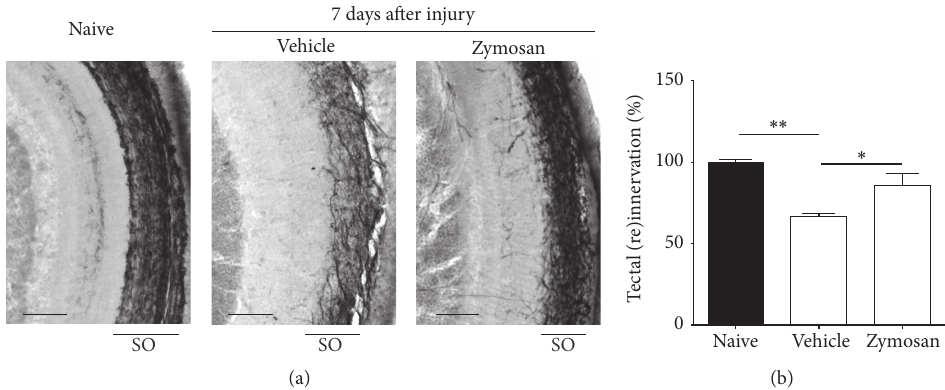
Figure 2: Intravitreal injection of zymosan accelerates axonal regeneration in zebrafish. (a) Representative images of biocytin-labeled axons in the contralateral optic tectum of naive fish (left) and fish treated with vehicle or zymosan, at 7 days after optic nerve injury (middle and right, resp.). The stratum opticum (SO), the layer through which the RGC axons innervate the tectum, is indicated. Scale bar = 50 𝜇 m. (b) Quantification of the reinnervated area of the optic tectum in fish treated with vehicle or zymosan at 7 days after injury, relative to naive fish. Intravitreal injection of zymosan significantly accelerates reinnervation, which is already close to naive levels in zymosan treated fish as compared to vehicle-injected fish. Data represent mean ± SEM ( 𝑛 ≥ 3 animals per group, ∗ 𝑝 < 0.05 , and ∗∗ 𝑝 < 0.01